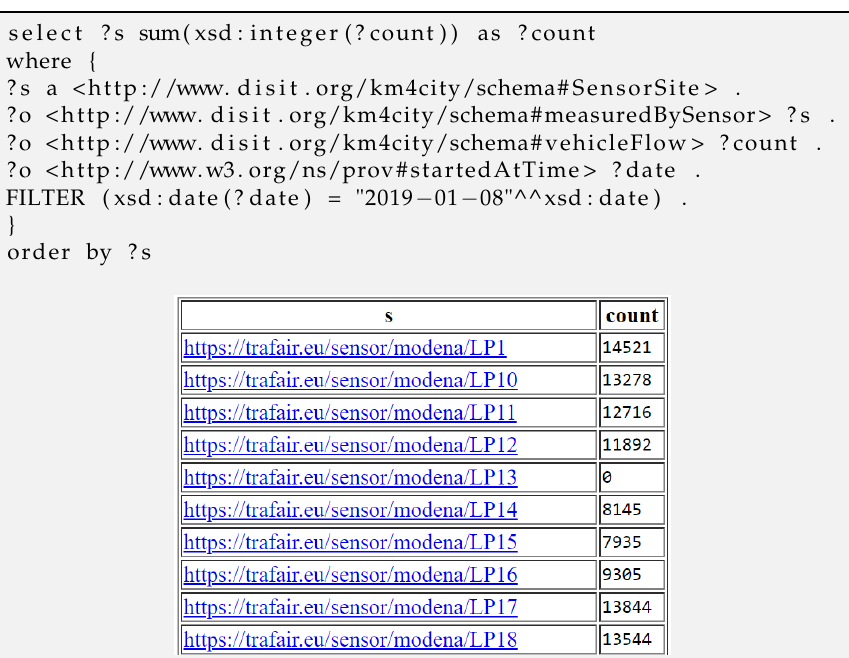
Figure A3. SPARQL query showing the number of vehicles counted by each sensor on 8 January 2019 (only a fragment of the answer is